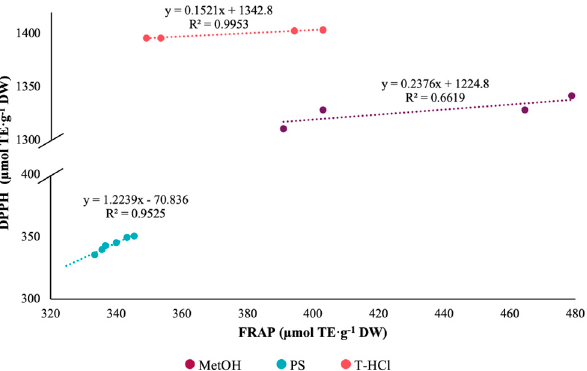
Table 6. Antioxidant activity from P. cruentum extracts ( µ mol TE · g − 1 PS). Extract